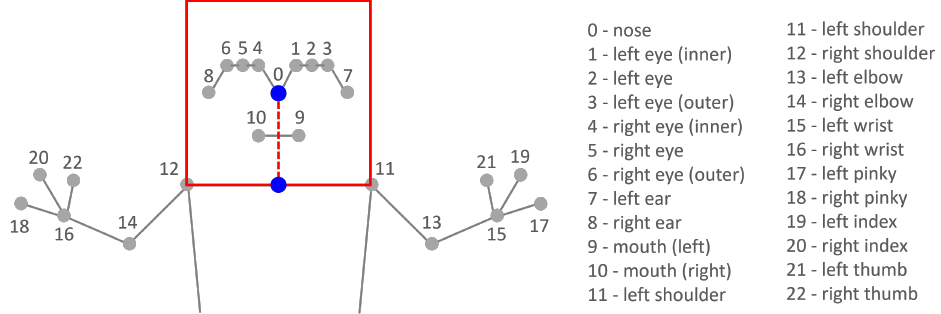
Figure 3. The head image is a square image with the nose as the center and twice the length from the nose to the neck as the side